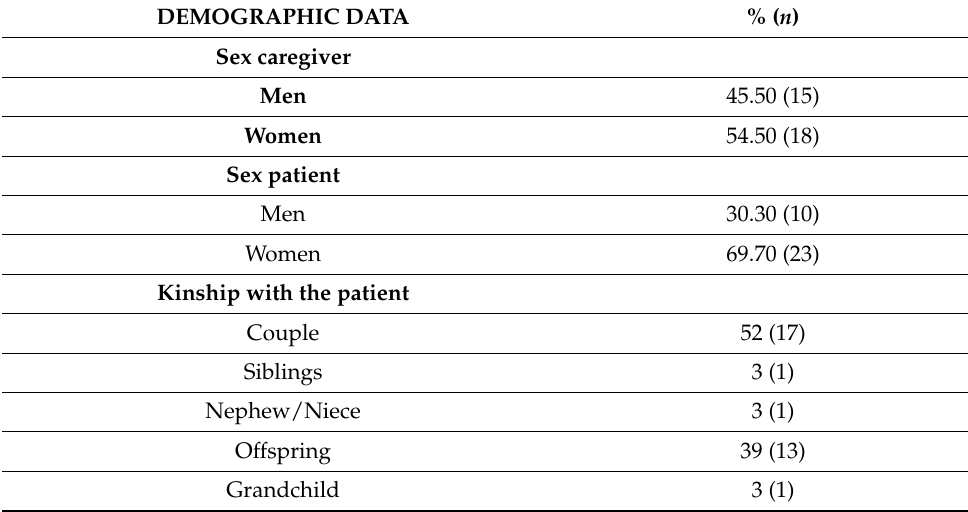
Table 1. Demographic data of study sample ( n =